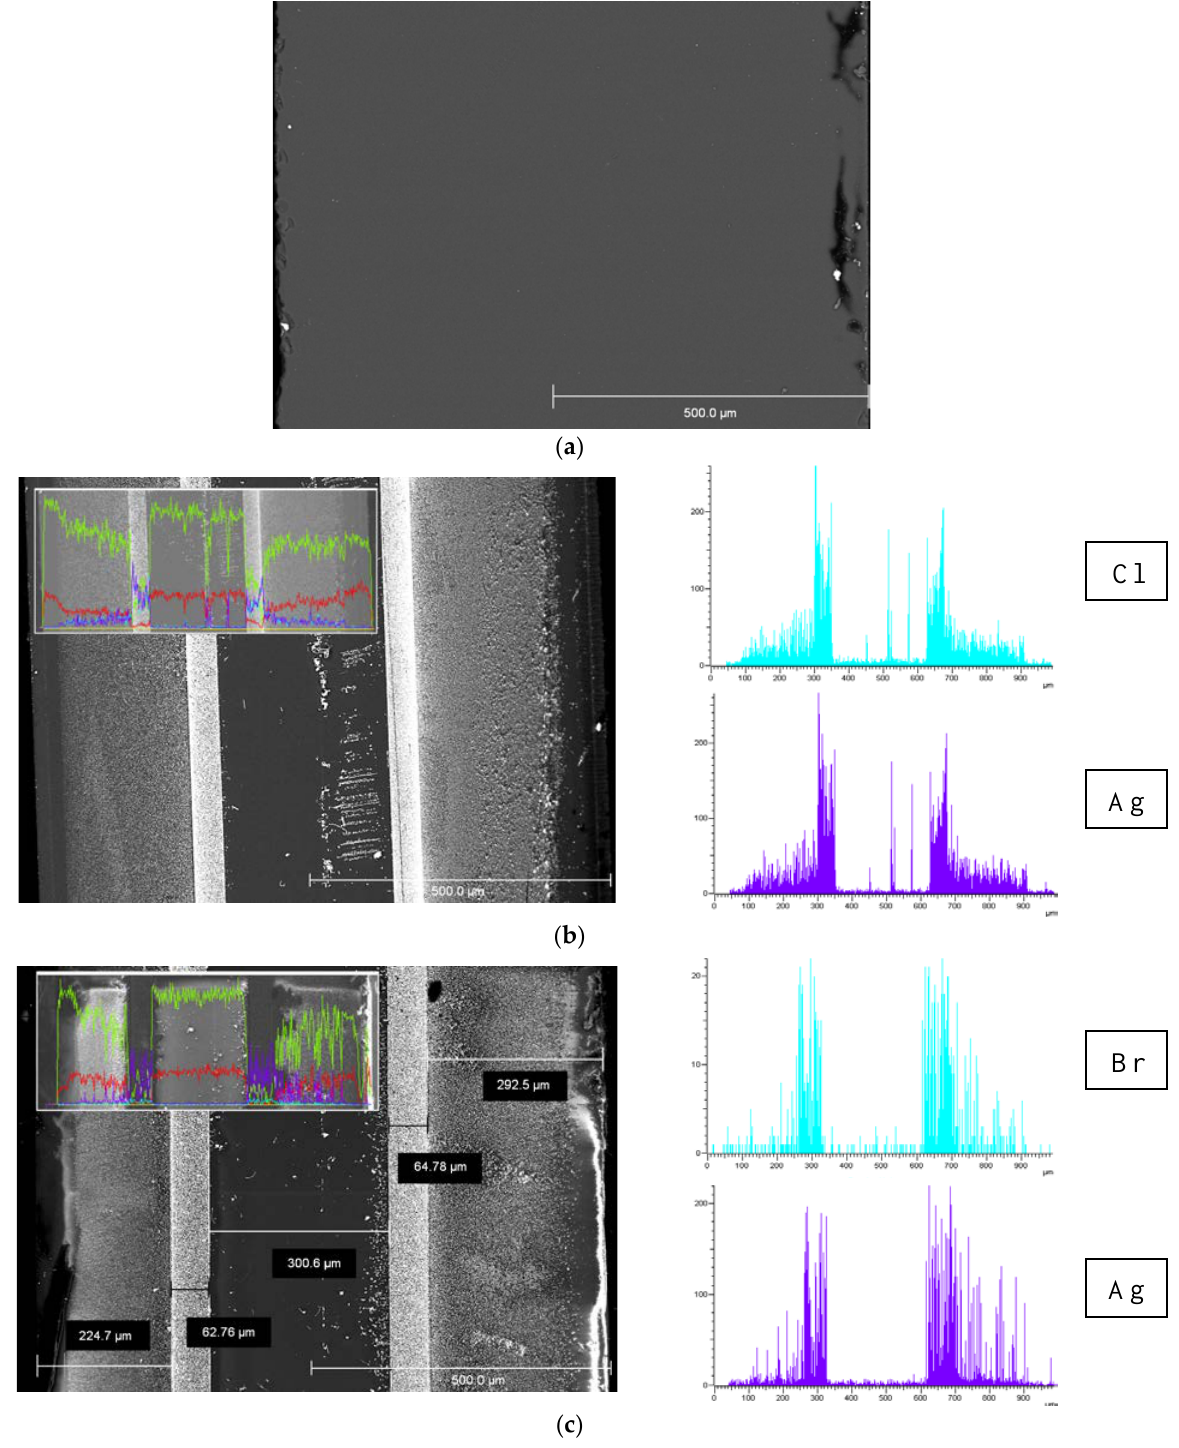
Figure 4. SEM images of the cross-section of the base MIP membrane ( a ) and MIP membranes modified by Ag/AgCl ( b ), Ag/AgBr ( c ) and element distribution over 1 mm thickness (Si—yellow, O—red, Cl/Br—blue, Ag—purple).